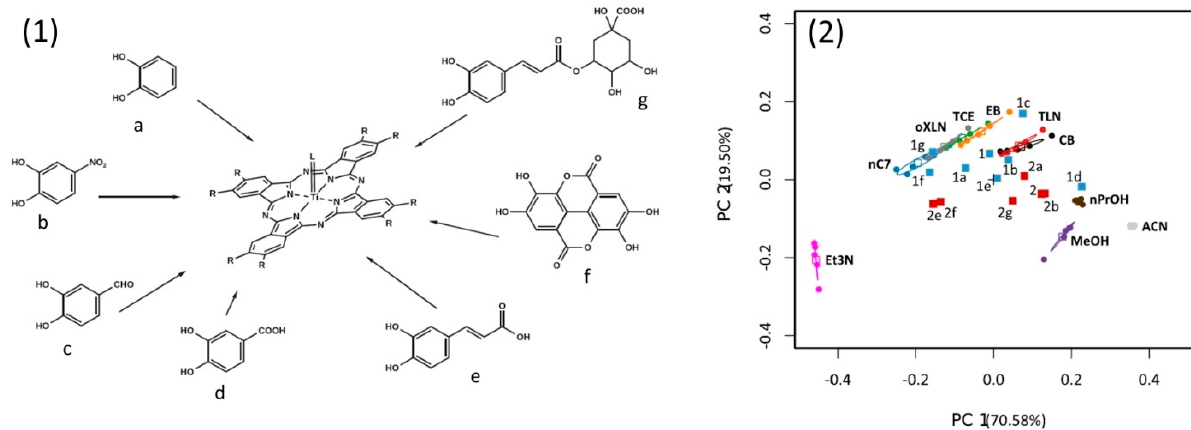
Figure 17. ( 1 ) The concept of obtaining a large set of phthalocyanine-based sensitive materials from a single starting compound by adding various axial ligands L to the metal ion center. ( 2 ) A PCA biplot showing the first two principle components obtained using the response data of the axially substituted TiOPc-coated QCM sensors. Loadings data are scaled to fit. Tetra- and octasubstituted TiOPcs are identified by blue or red squares. Reprinted from [54] with permission from Elsevier.